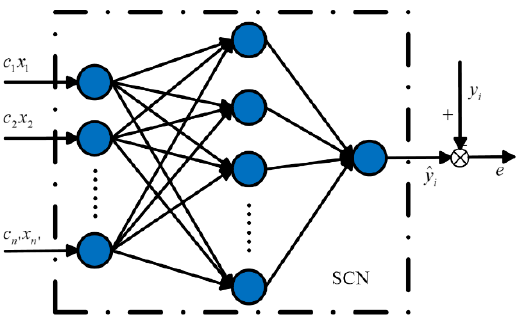
Figure 3. The error of SCN incinerator temperature